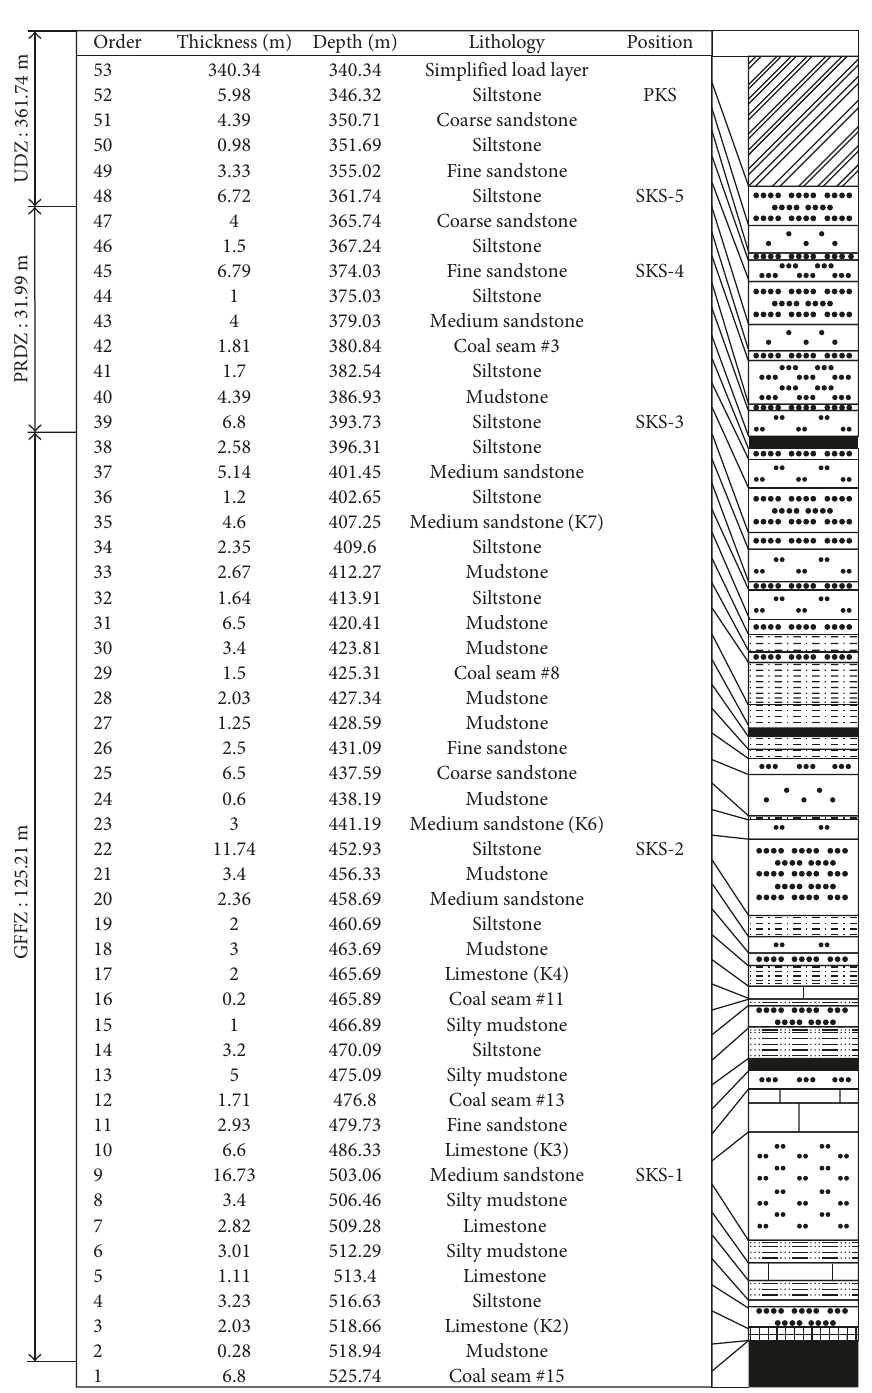
Figure 6: Identification results of overlying key strata at FMWF